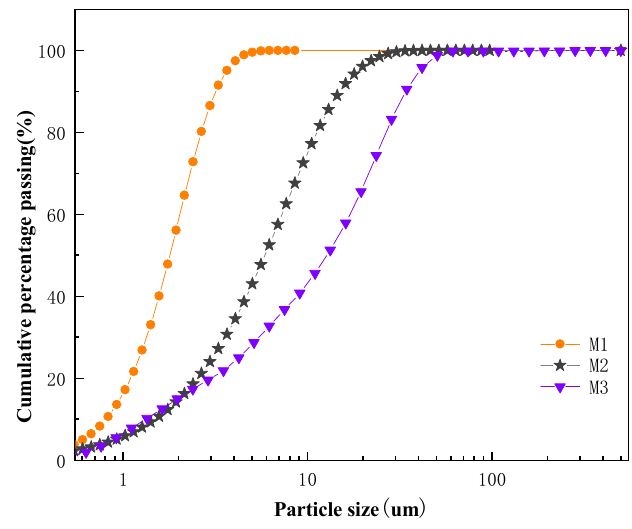
Figure 3. Particle size distribution curve. Table 2. Chemical compositions of the raw materials (wt%).